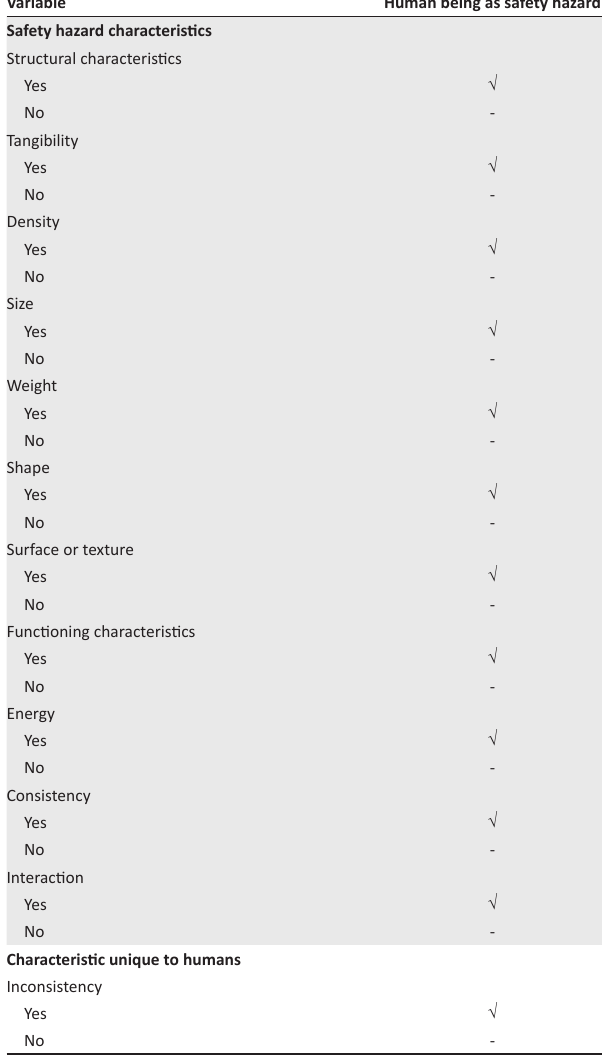
TABLE 3: Congruency of the human as safety hazard with safety hazard characteristics. Variable